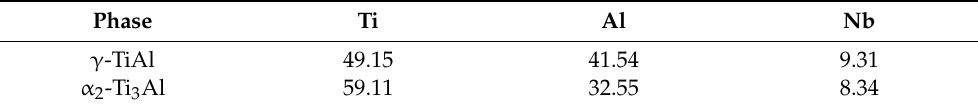
Table 1. The composition of γ -TiAl and α 2 -Ti 3 Al